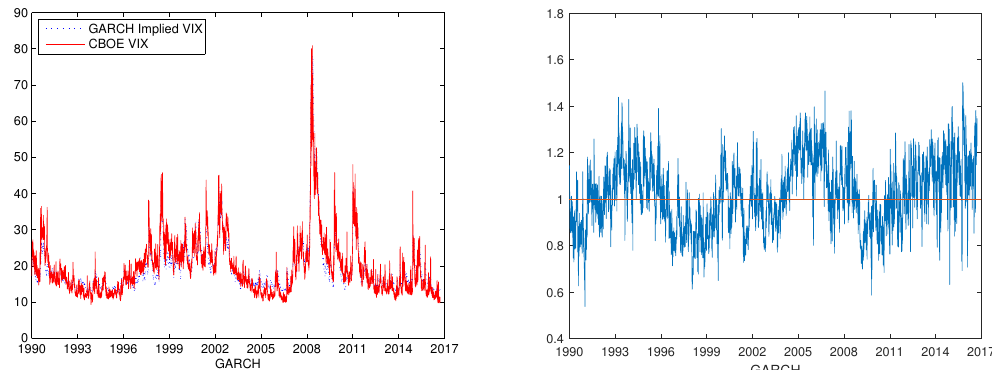
Figure 2. Comparison between CBOE VIX and implied VIX of the GARCH(1,1) model using VIX data only. The left panel shows the index values of CBOE VIX and implied VIX and the right panel shows the ratio of the implied VIX to CBOE VIX and a horizontal line at 1 for reference.